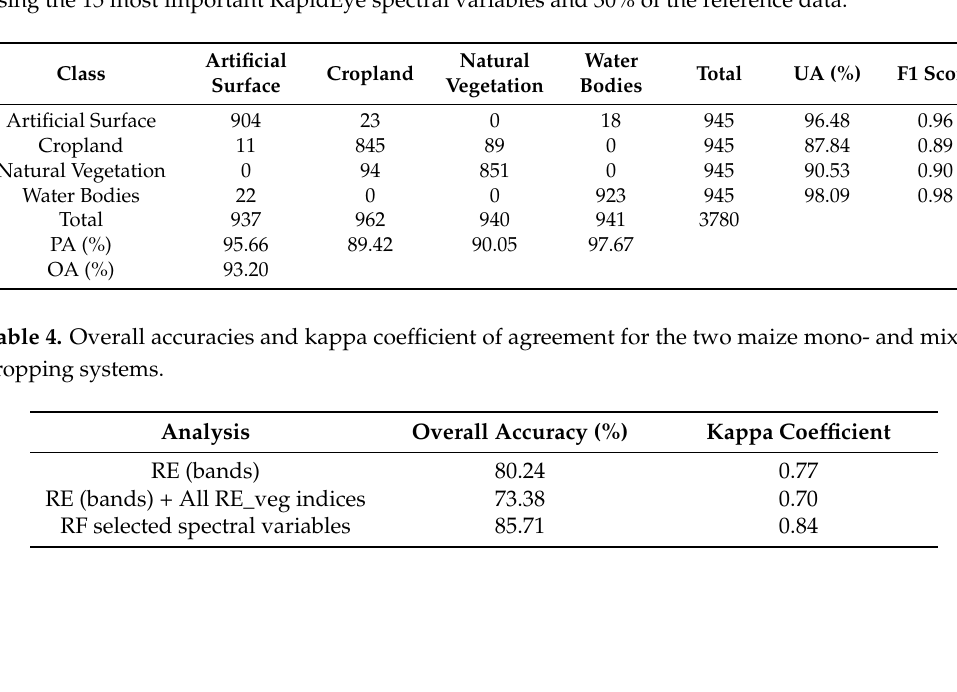
Table 3. Random forest classification confusion matrix for the land use/land cover classes (level 1) using the 15 most important RapidEye spectral variables and 30% of the reference data.